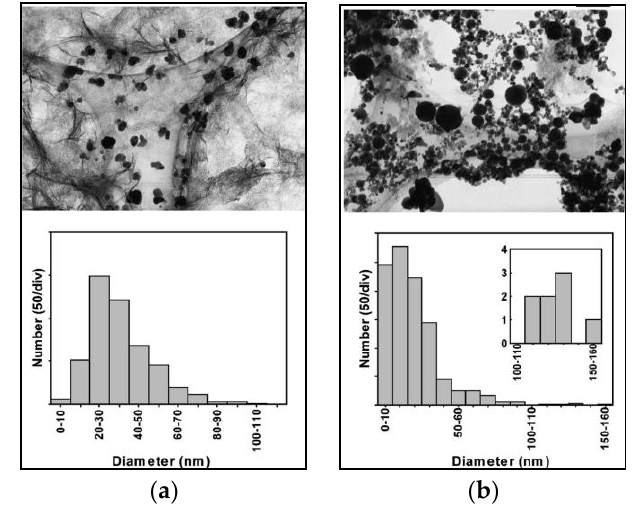
Figure 7. TEM images and size distribution of silver colloids prepared by ( a ) 120-fs and ( b ) 8-ns laser pulses. Reprinted from [173], with permission from Elsevier.